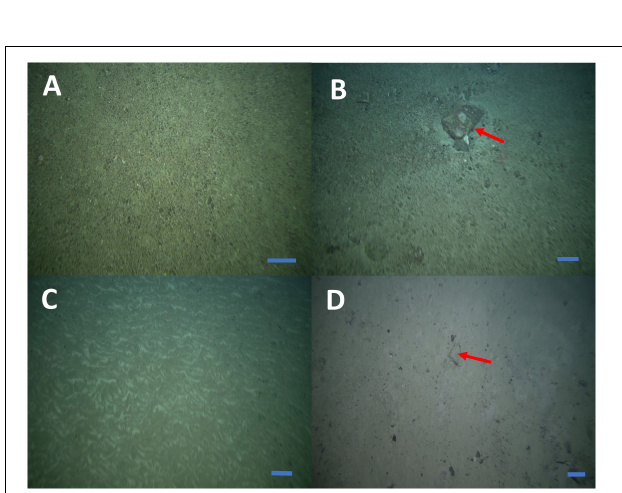
FIGURE 4 | Categories of substrate types inside and outside the Faroe-Shetland Channel Nature Conservation Marine Protected Area FSC NCMPA. Cobble (A) , cobble with boulder (B) , sand (C) , and sand with boulder (D) . Scale bars: 30 cm. Red arrows show